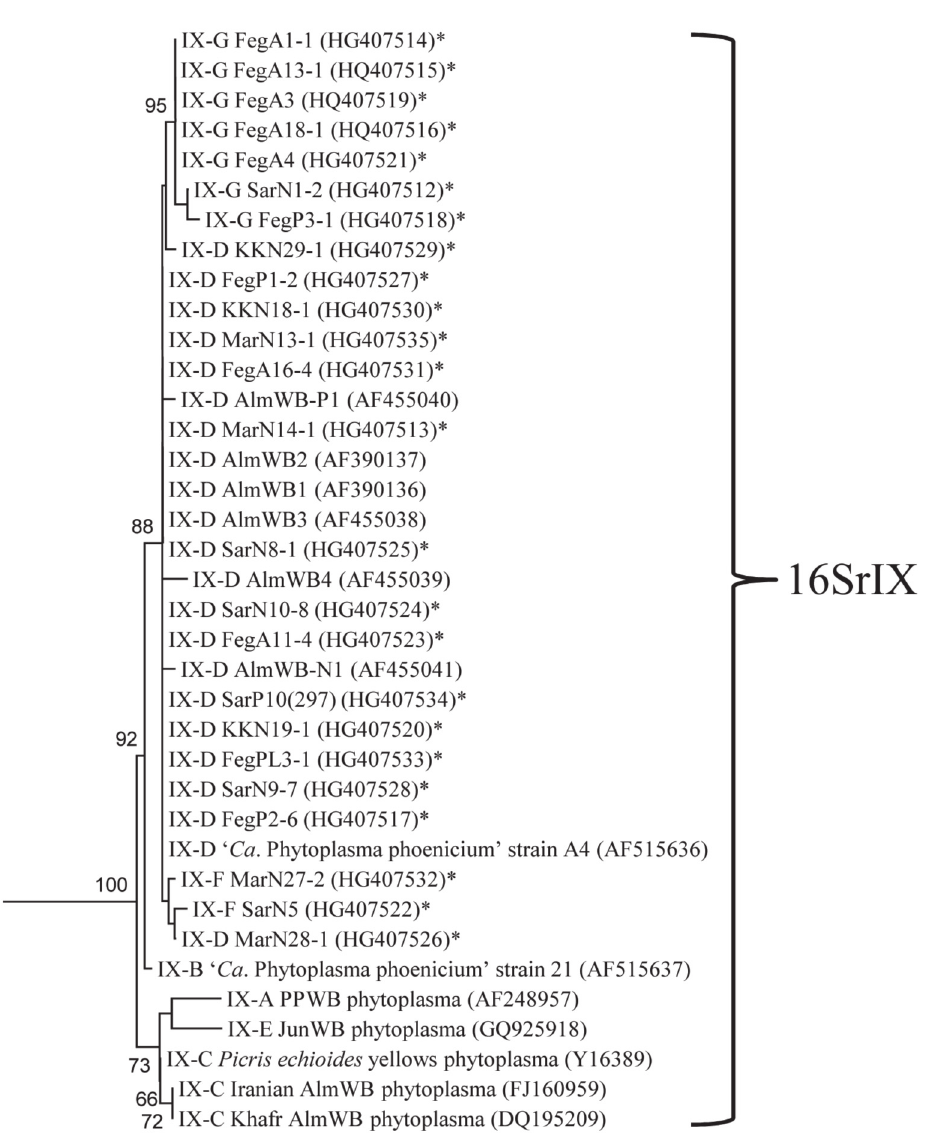
Figure 4. Group 16SrIX branch in phylogenetic tree inferred from phytoplasma 16S rDNA R16F2nR2 sequences. Bootstrap values are displayed at tree nodes. GenBank accession numbers of nucleotide sequences are shown along with the name of phytoplasma strains. Nucleotide sequences determined in this study are indicated by